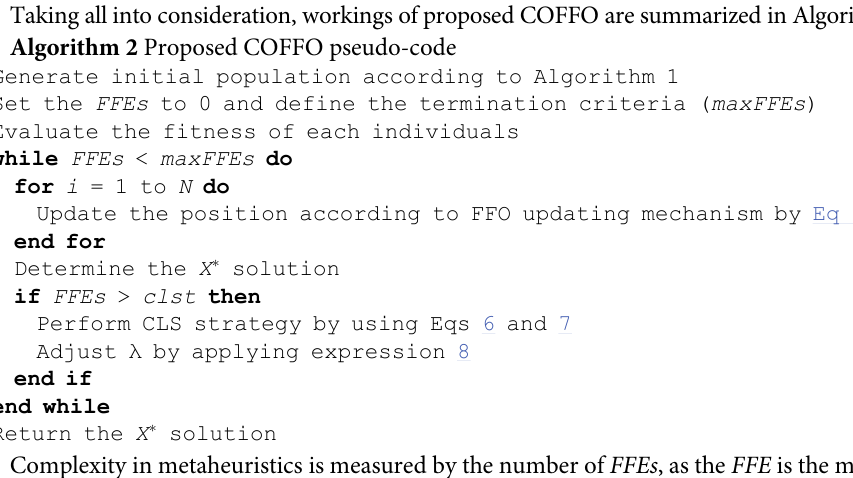
Algorithm 2 Proposed COFFO